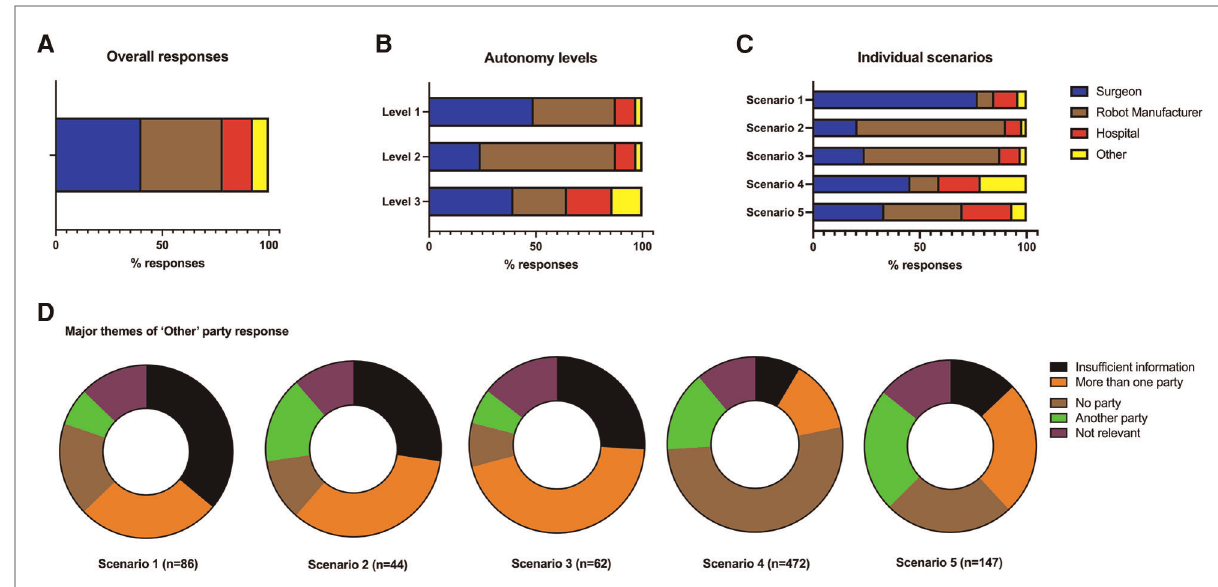
FIGURE 2 A total of 10,955 individual scenario responses were captured from 2,191 respondents. Bar charts demonstrating the overall responses across the fi ve scenarios ( A ) the levels of autonomy ( B ) and the individual scenarios ( C ). The comments from another party option were collated and qualitatively then quantitively analysed ( D